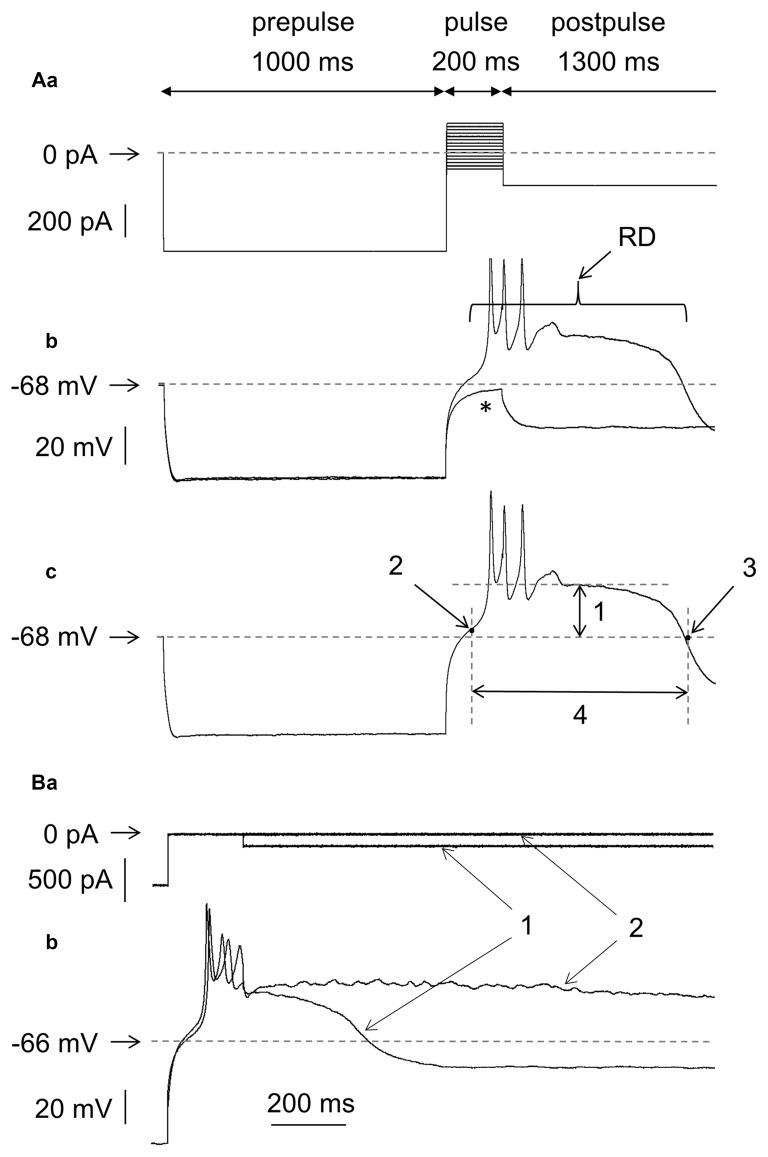
Measurements of the amplitude and duration of rebound depolarization (RD) in medial prefrontal cortex (mPFC) pyramidal neurons. (Aa) Standard protocol applied to study RD. A 600-pA hyperpolarizing current prepulse lasting 1000 ms preceded 200-ms current pulses applied in 20-pA increments from −100 pA to +180 pA. The 200-ms current pulses were followed by a hyperpolarizing current postpulse at −200 pA that lasted 1300 ms. (b) Membrane potential changes evoked by current pulses −20 pA (*) and 0 pA (RD) in the bath in the absence of Ca++. (c) An RD taken from (b). Double-headed arrow 1 indicates maximum depolarization above the resting membrane potential attained after repetitive tetrodotoxin (TTX)-resistant spikelets. Arrow 2 indicates the beginning of RD when the depolarization phase of the RD attained 10% of its maximum level. Arrow 3 indicates the RD end, which was defined as the time point at which the RD repolarization phase intersected with the resting membrane potential level. Double-headed arrow 4 indicates the RD duration, defined as the time interval between the beginning and the end of the RD. (B) Voltage changes (b1,b2) evoked by a current pulse to 0 pA (a) followed by postpulses to −200 pA (a1) and postpulse 0 pA (a2). The dotted horizontal line in panel (Aa) indicates 0 pA and the dotted horizontal lines in panel (Ab,c,Bb) and other figures indicate the resting membrane potential level.